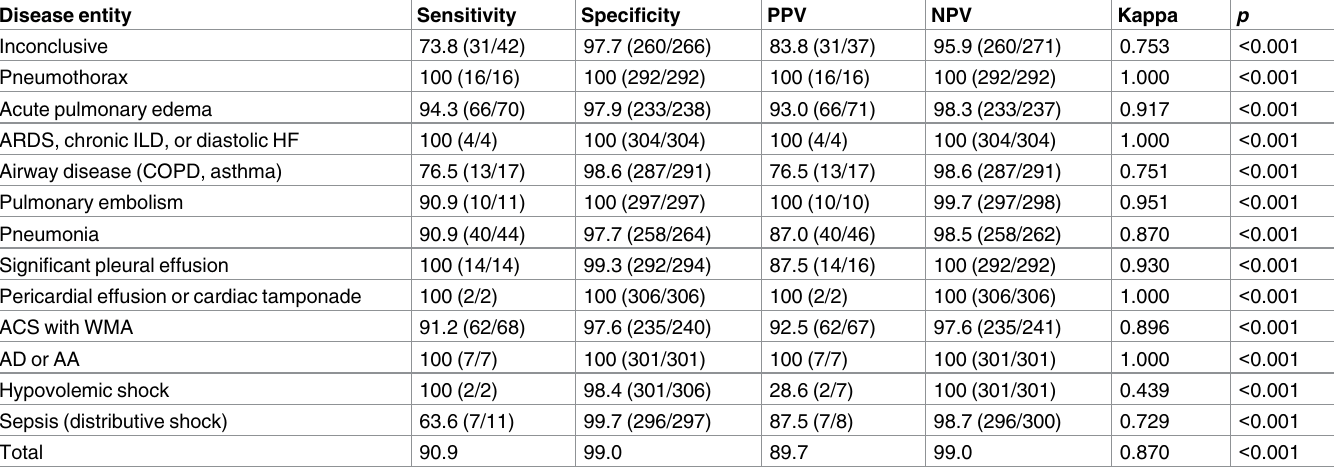
Table 2. Accuracydata of the SEARCH 8Es protocol for the 13 target disease entities